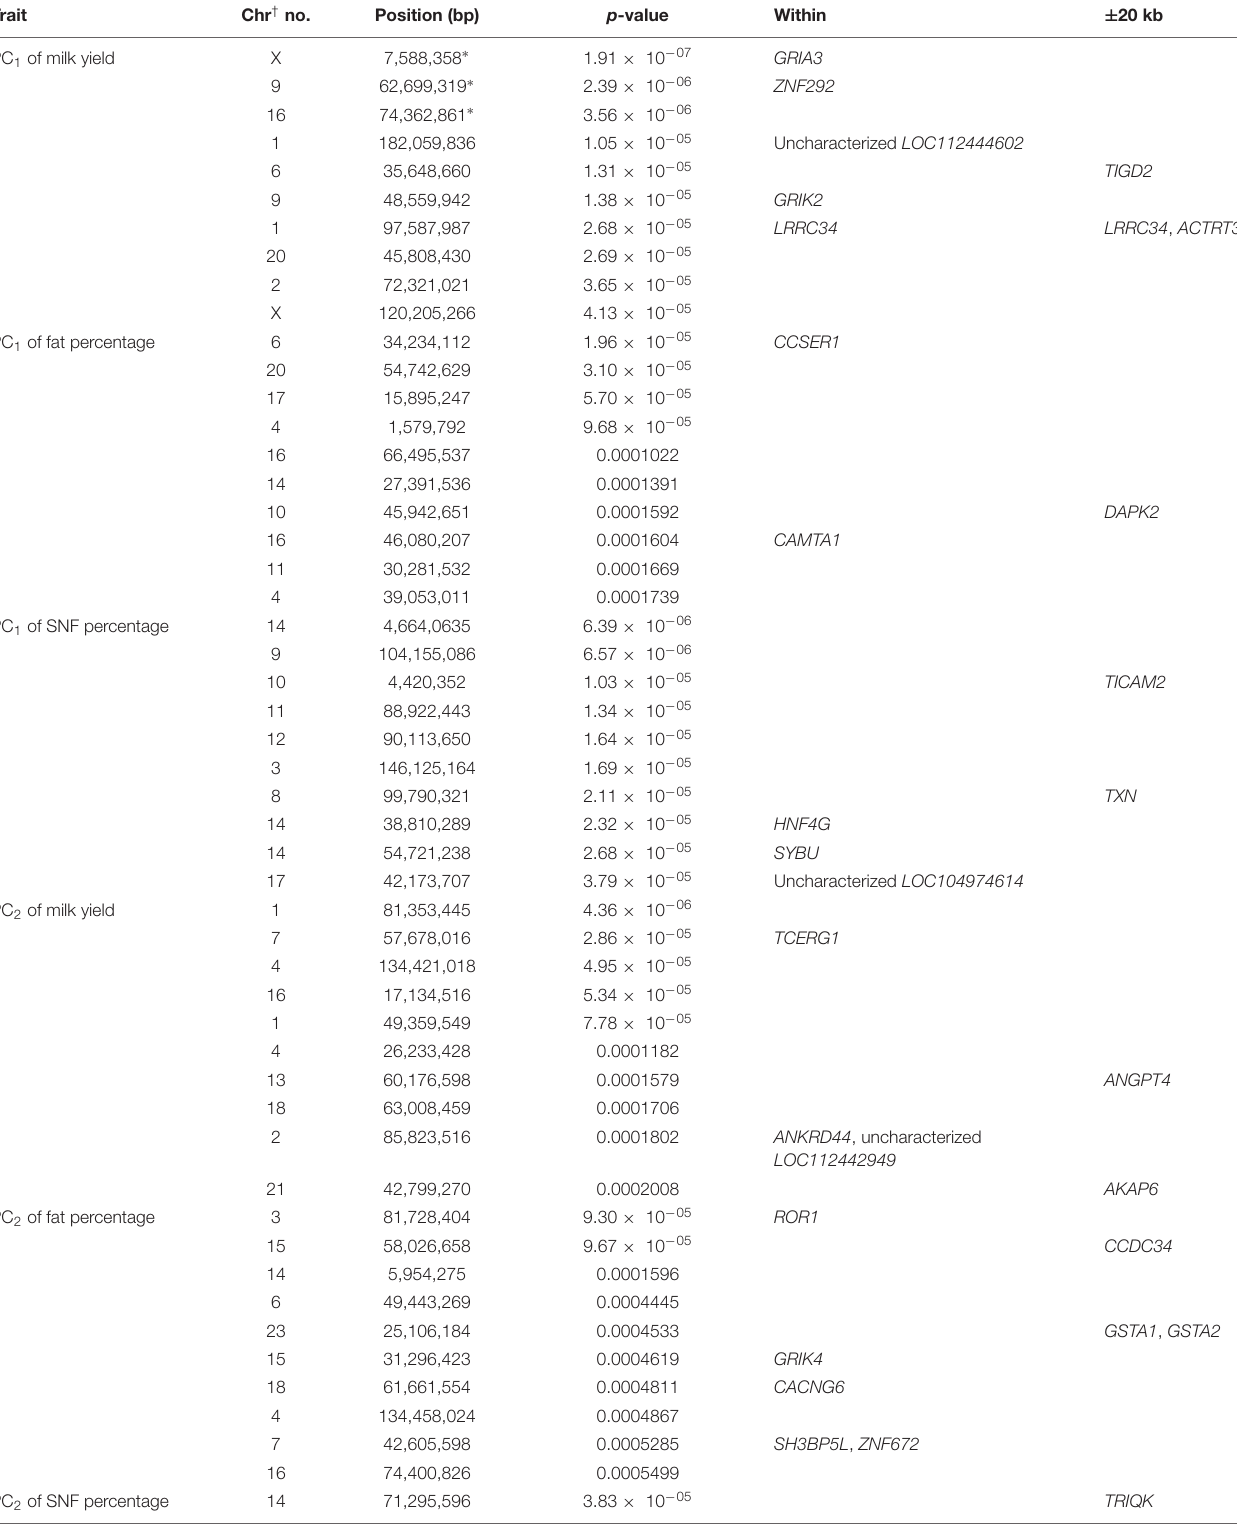
TABLE 1 | Details of the top 10 SNPs identified through GWAS on various traits and genes identified through genome scan. Trait Chr † no. Position (bp) p -value Within ± 20